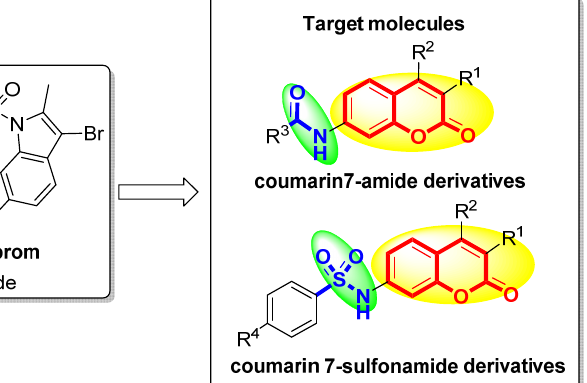
Figure 3. Design strategy for target molecules.